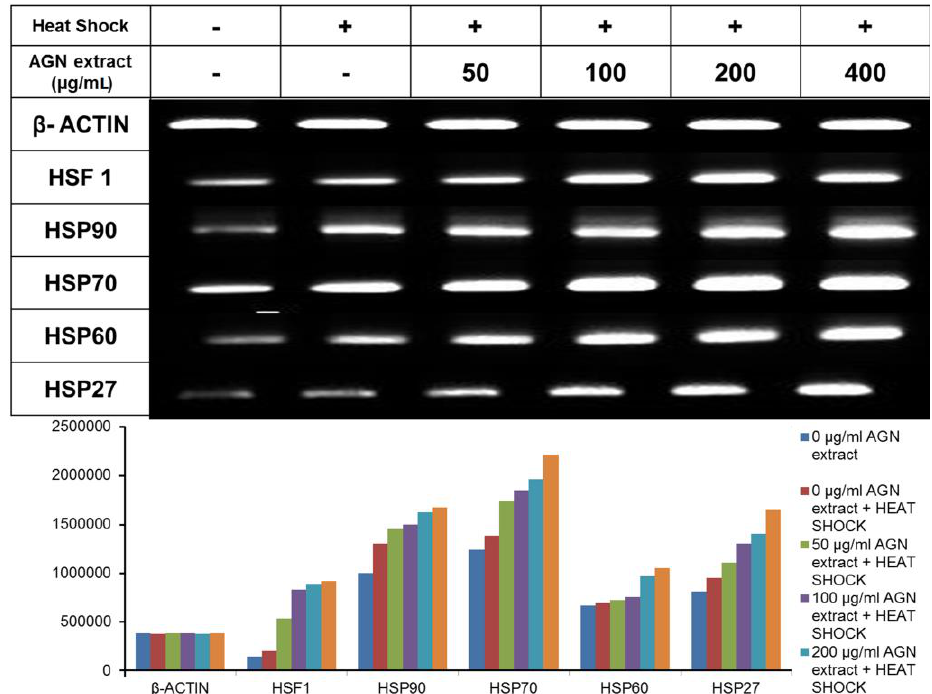
Figure 4. mRNA expressions with densitometry measurements of heat shock related genes in the differentiated murine 3T3-L1 after heat shock procedure at G0 stage, recovery and then treatment with Angelica gigas Nakai root hot water extract (0, 50, 100, 200, and 400 μg/mL) prior to differentiation